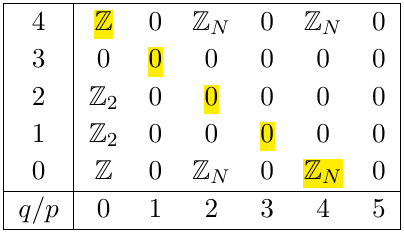
Table 1 . E 2 page for odd N .